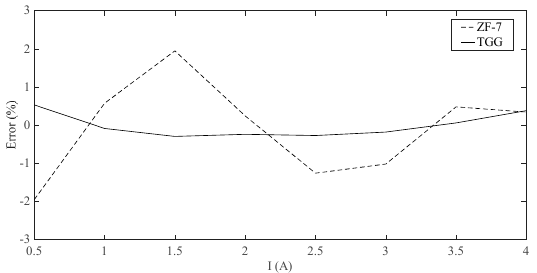
Figure 8. Measurement curves of TGG and ZF-7. Figure 9. Comparison of measurement errors of TGG and ZF-7.